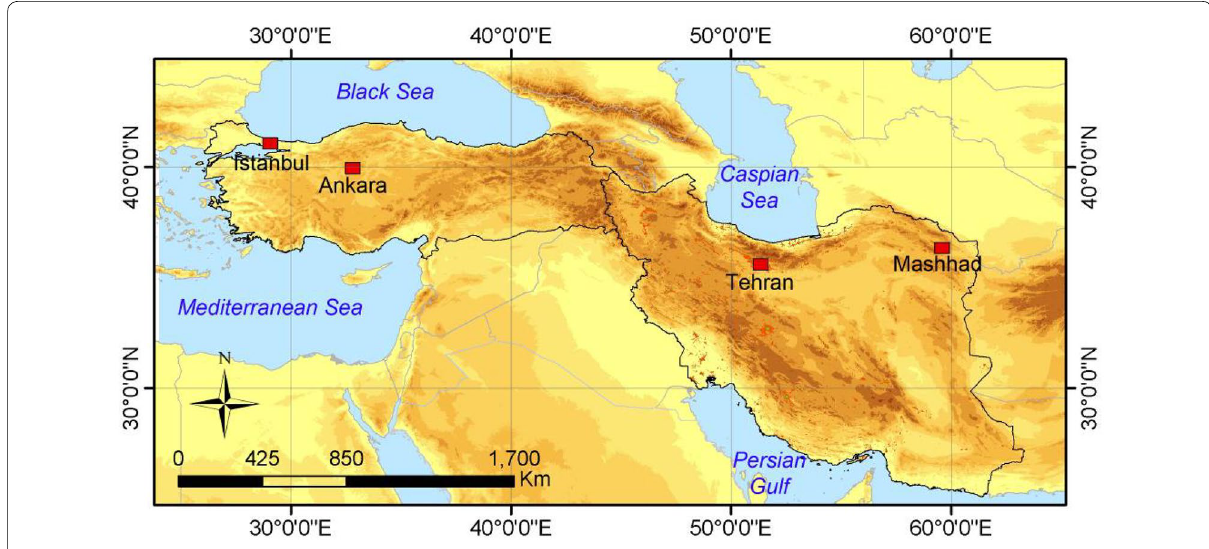
Fig. 1 Geographical location of the study